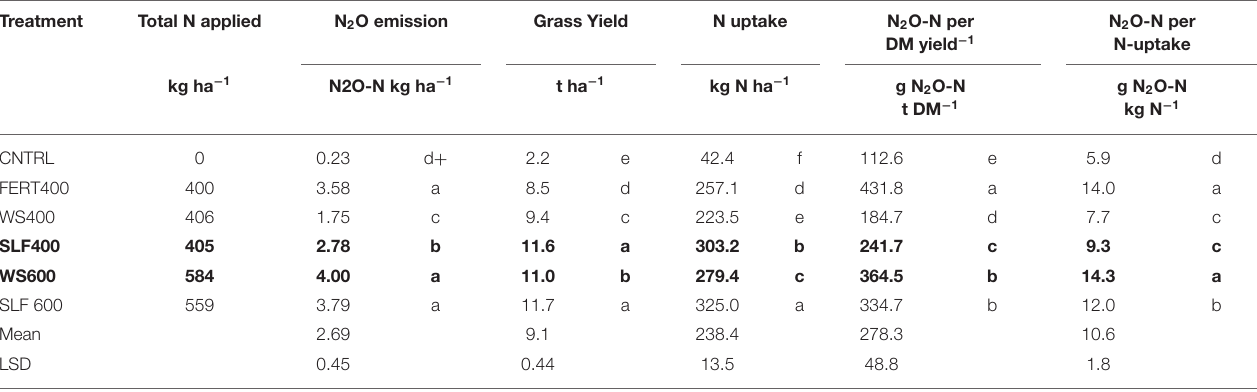
TABLE 6 | Mean annual N 2 O emissions per ha, per DM yield, and per N uptake from perennial tall fescue grass treated with whole slurry (WS), separated liquid fraction (SLF), and mineral fertilizer at different rates of N.